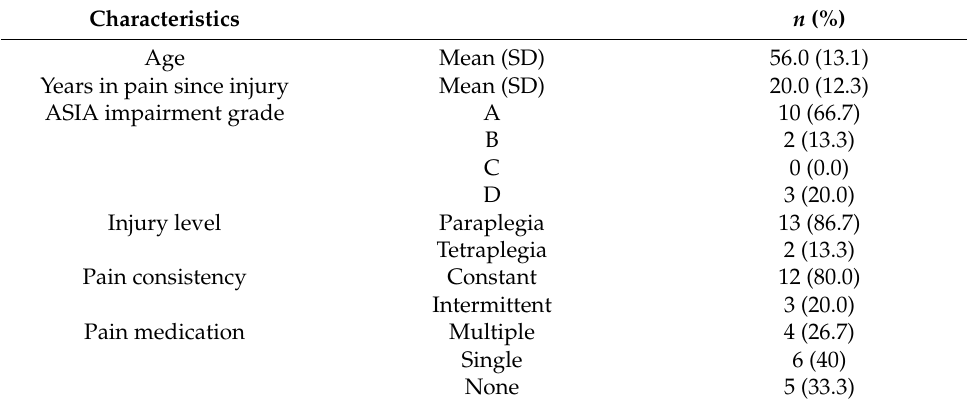
Table 1. Participant demographic characteristics ( n = 15).